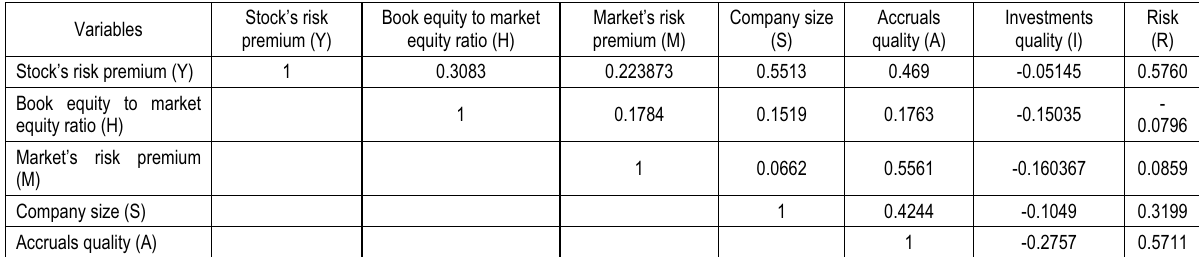
Table 5. Alignment between